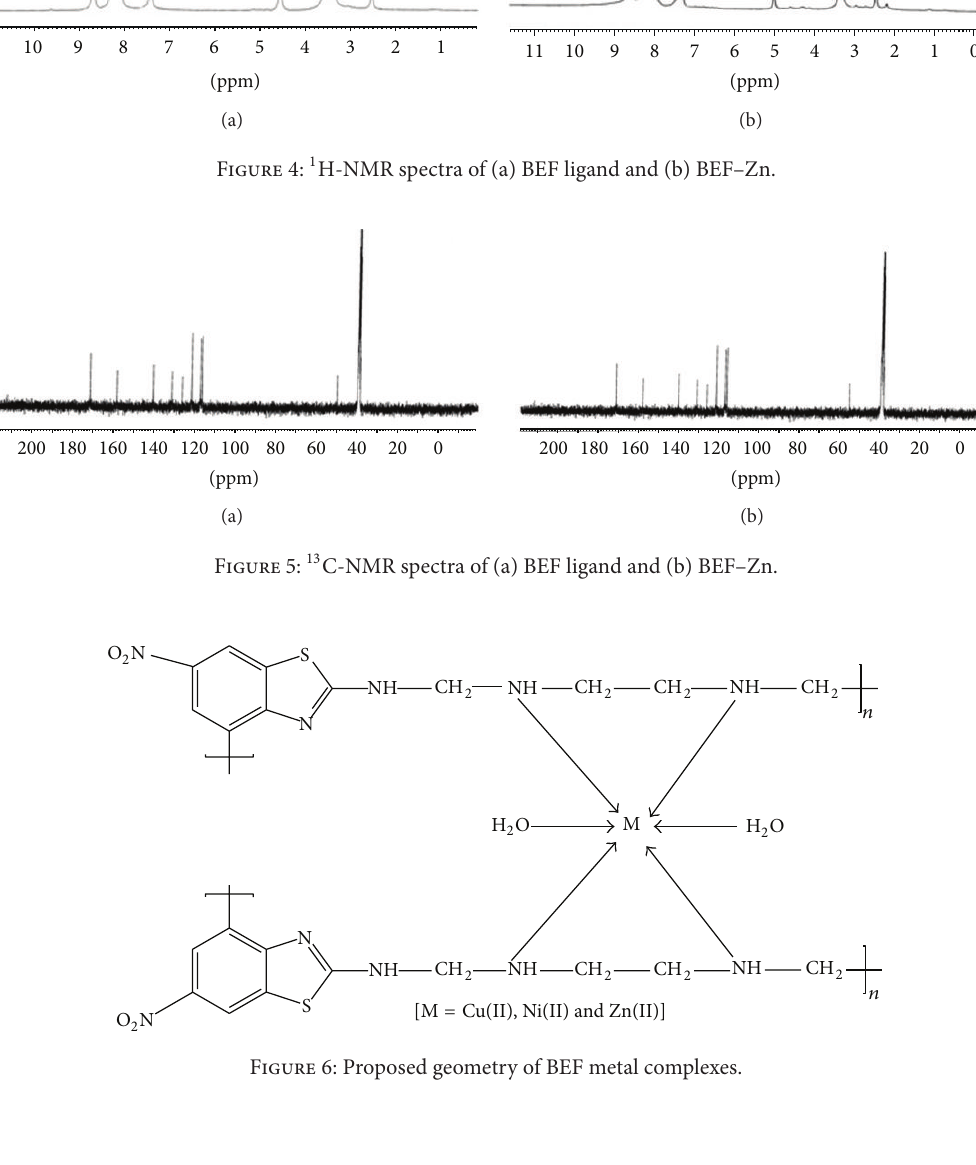
Figure 5. The observed chemical shifts are assigned on the basis of the literature [22, 27]. The spectrum of ligand showed that the corresponding peaks at 171.7, 158.5, 131.5, 121.9,